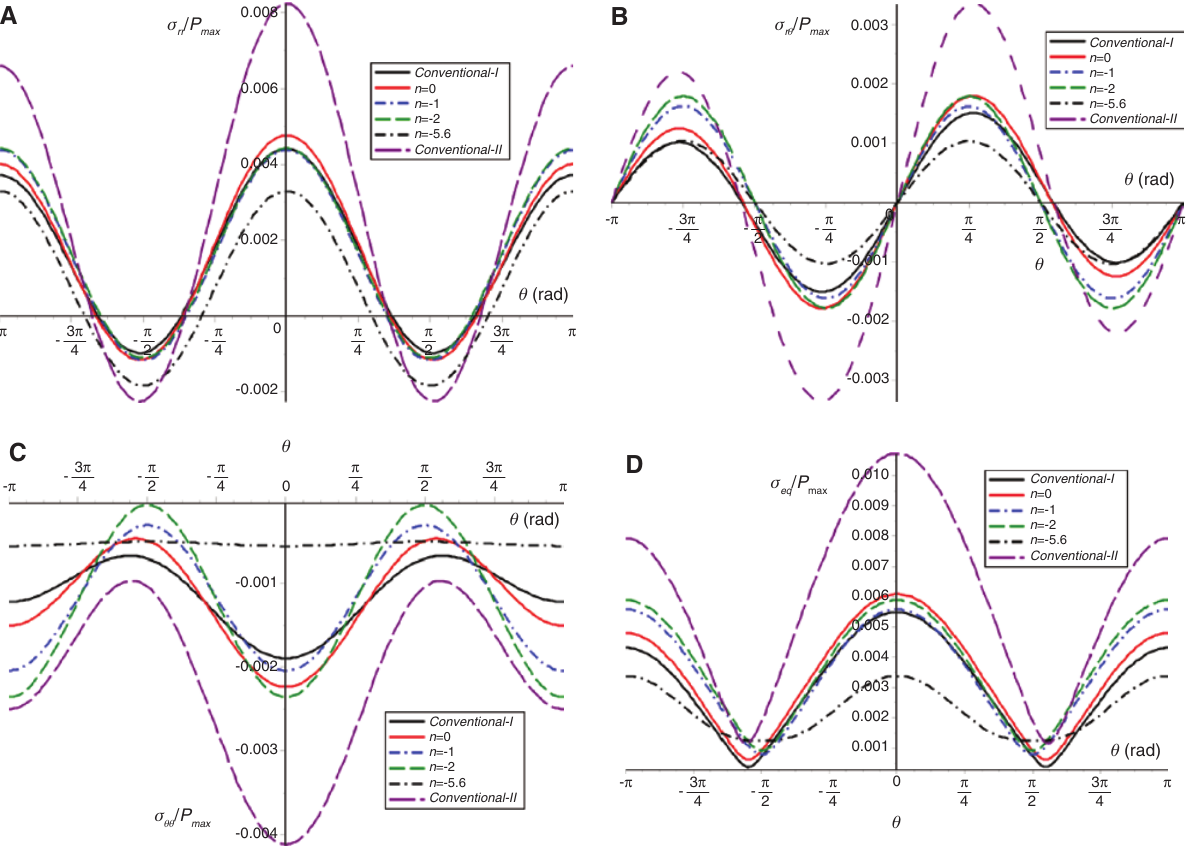
Figure 13: The non-dimensional stresses around the joint edges at r = 40.1 mm: (A) radial stress profile, (B) shear stress profile, (C) hoop stress profile, and (D) equivalent stress